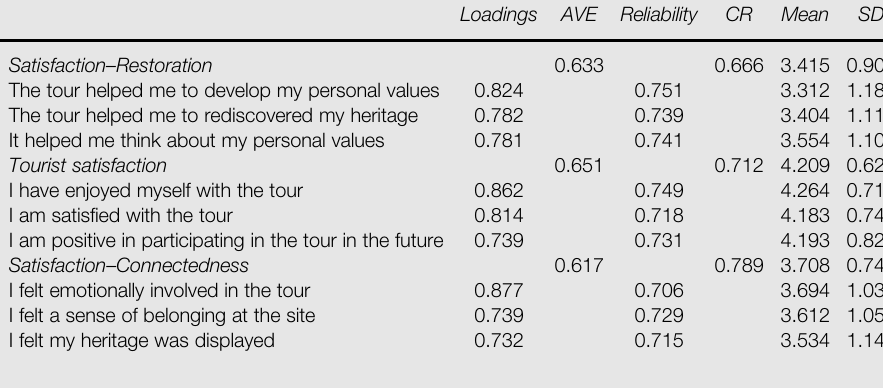
Table IV Factor analysis of youth tourist ’ s satisfaction